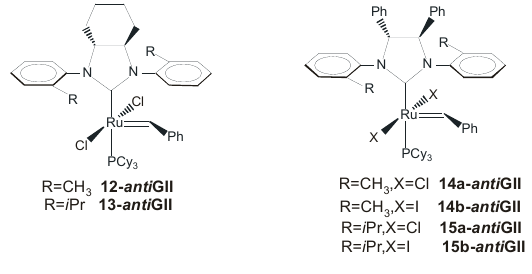
Figure 12. Catalysts 12-GII – 15-GII bearing monodentate NHCs with anti